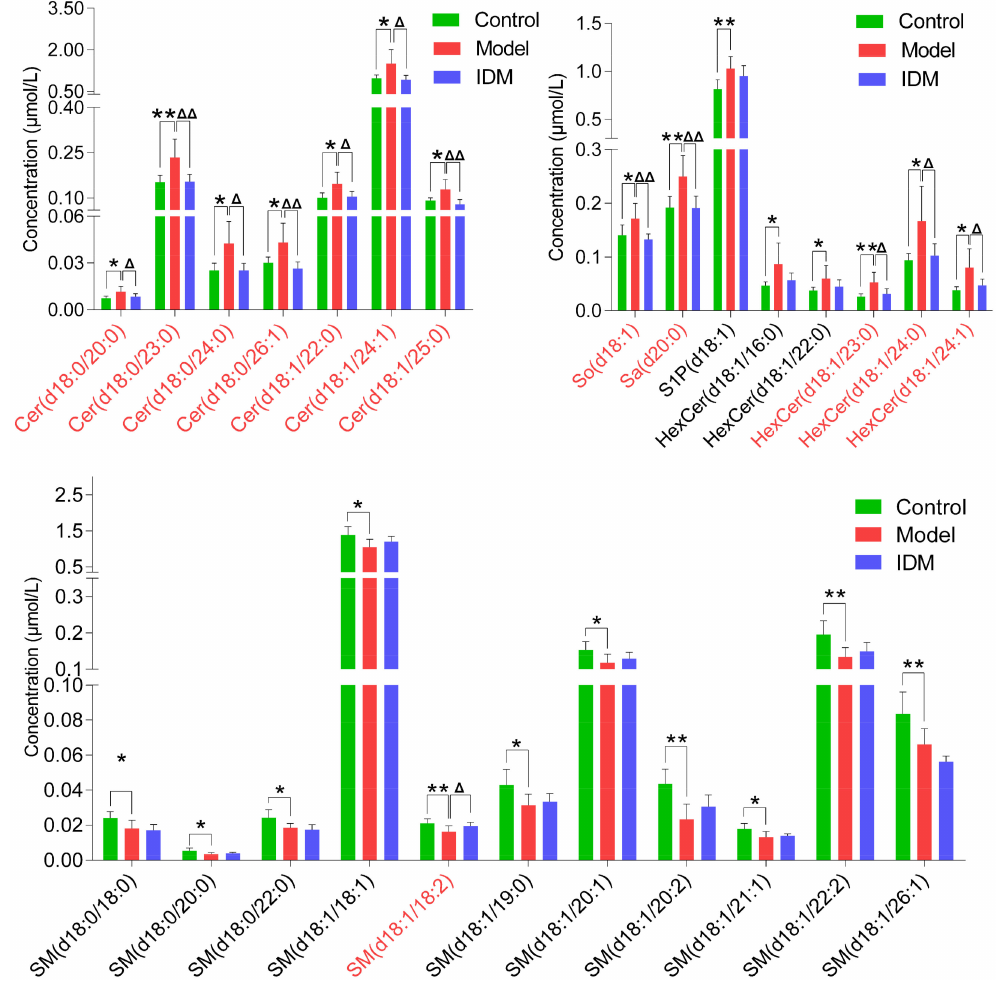
Figure 5. Altered levels of SPL markers in the control, model and IDM-treated rats. Data are represented as mean ± SD ( n = 7 in each group). *, ∆ p < 0.05 and **, ∆∆ p < 0.01 from one-way ANOVA analysis. The markers colored in red indicate their levels were significantly reversed by IDM treatment. Cer, Ceramide; So, sphingosine; Sa, sphinganine; S1P, sphingoid-1-phosphate; HexCer, hexosylceramide; SM,